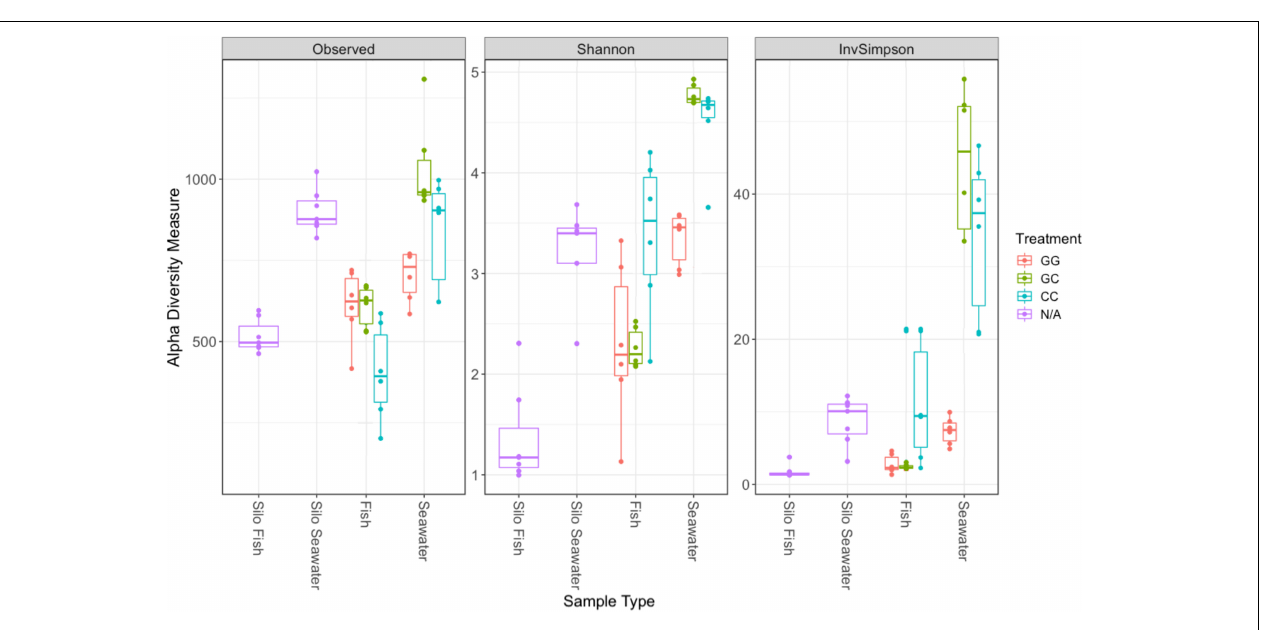
FIGURE 7 | Alpha diversity metrics for samples collected on the final sampling date (fish, seawater) and samples collected prior to the start of the experiment (silo fish, silo seawater). Samples from hatching silos are designed “N/A” because they were not subjected to experimental treatments. Richness estimate means and theoretical standard error ranges are shown by the boxplot for each sample type and